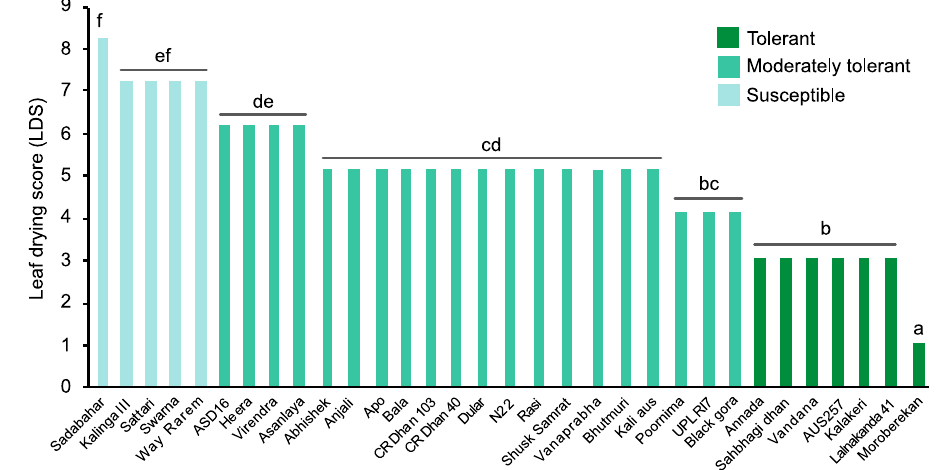
Figure 2. Drought sensitivity in terms of leaf drying score of 32 rice cultivars. Different letters on the bars indicate statistically significant difference as determined by DMRT analysis. The figure was edited for presentation using Affinity Designer 1.9.3 (https:// affin ity. serif. com/ en-